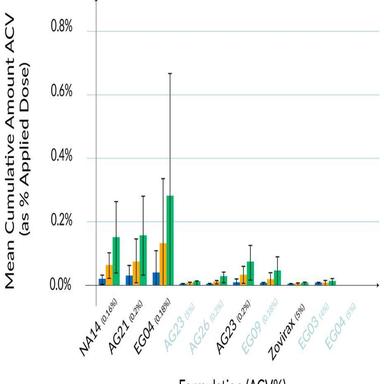
IVPT results: Mean cumulative amount of ACV (expressed as % applied dose) delivered to the receptor solution 0.5 h (blue/left bars), 1 h (orange/middle bars) and 2 h (green/right bars) post application of nine test formulations and Zovirax® 5% cream. Bar represents the cumulative amount of ACV (expressed as % applied dose) from seven replicates and one donor (n = 7). Error bars represent standard deviation of the mean.